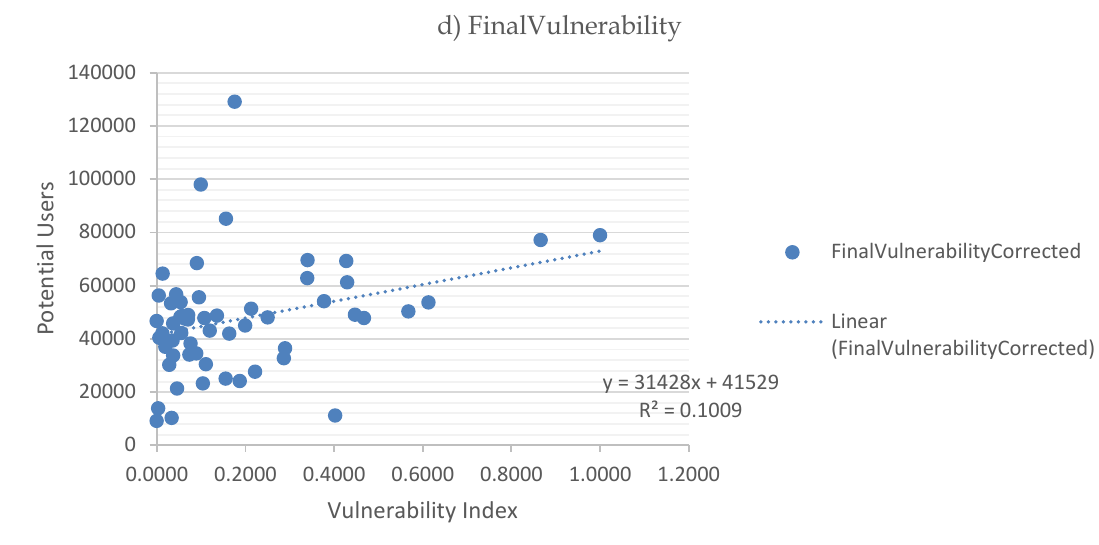
Figure 12 Vulnerability Index by station and potential users per weather condition